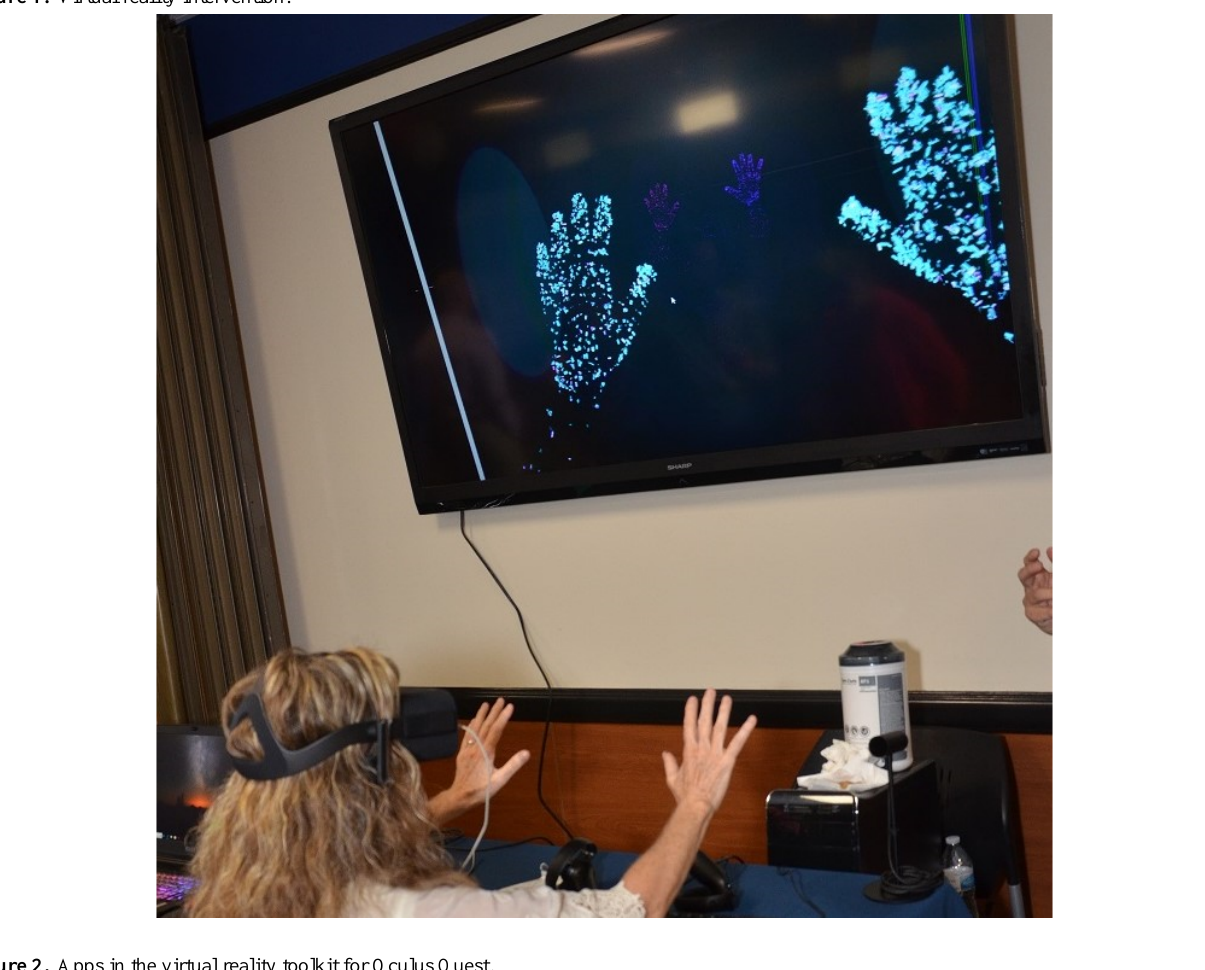
Figure 1. Virtual reality intervention.